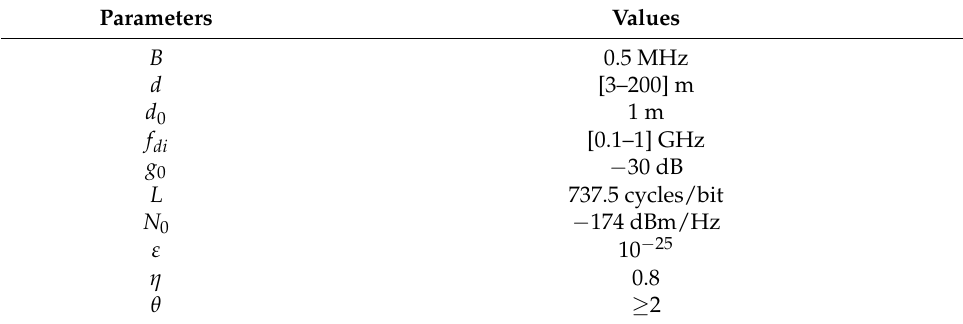
Figure 3. Accuracy vs. training dataset size. Table 4. Simulation